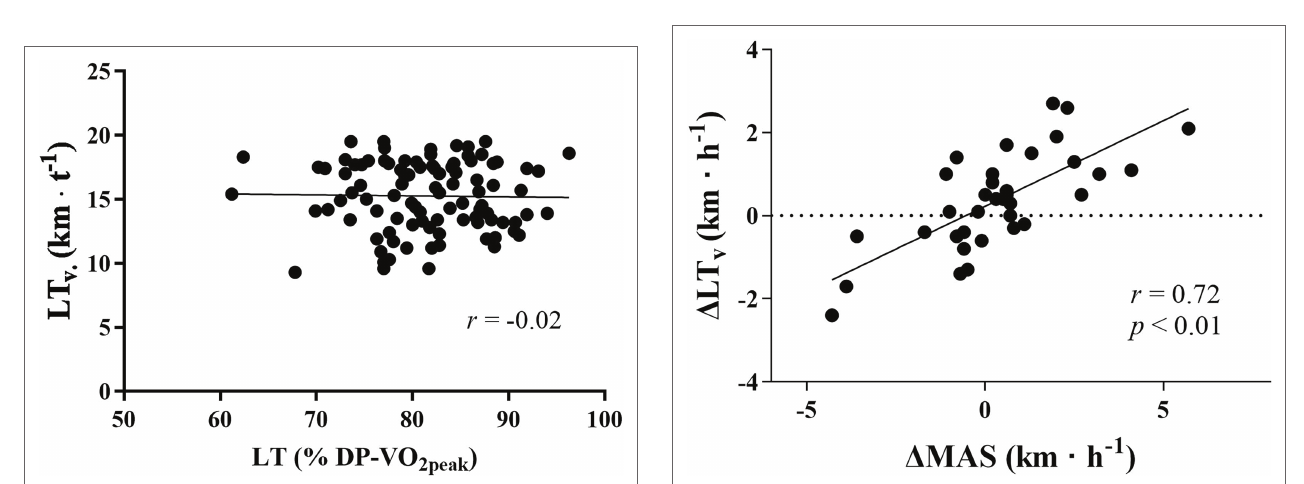
FIGURE 5 | Delta correlation between change in MAS and change in LT v . ∆ LT v ; change in velocity at lactate threshold; ∆ MAS, change in maximal aerobic speed; km·h − 1 , kilometers per hour; and r , correlation